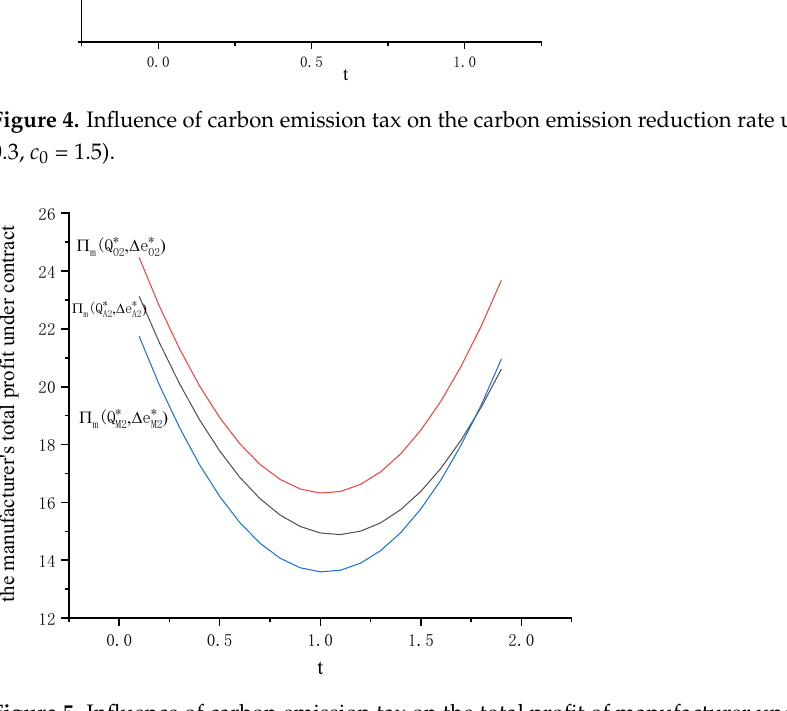
Figure 5. Influence of carbon emission tax on the total profit of manufacturer under contracts.